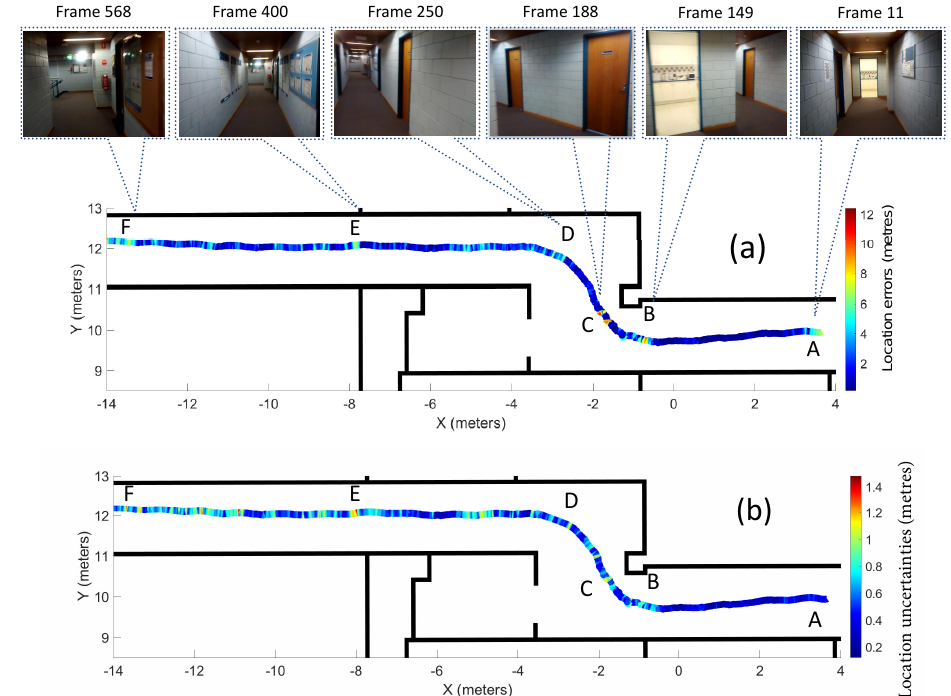
Figure 11. The distribution of the ( a ) location errors and ( b ) estimated location uncertainties along the trajectory for the network fine-tuned using Gradmag-Syn-car dataset. The first row shows some of the frames with large location errors near Points A–E. Table 3 shows the errors and estimated uncertainties of the